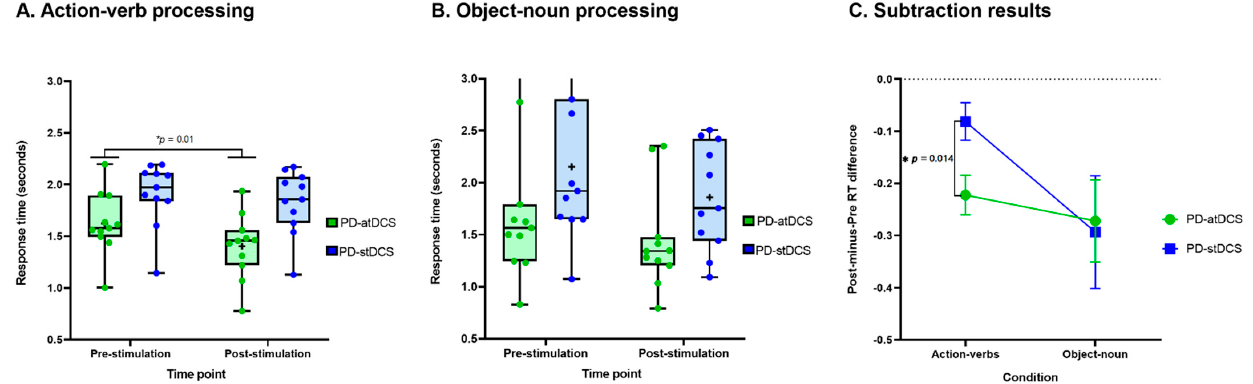
Figure 2. Behavioral results. ( A ) Response times for the action-verb condition revealed faster performance for the PD-atDCS than the PD-stDCS group. ( B ) Response times for the object-noun condition did not differ significantly between groups. ( C ) The subtraction analysis confirmed that the between-group difference proved consistent even when controlling for potential differences in baseline performance. The box and whisker plots in ( A , B ) show the distributions of RTs in the groups, with the boxes representing the inter-quartile range, the horizontal line within the boxes representing the median, and the points representing the individual mean RTs. The error bars in ( C ) represent standard error of the mean (SEM). PD-atDCS, Parkinson’s disease patients undergoing anodal transcranial direct current stimulation; PD-stDCS, Par- kinson’s disease patients undergoing sham transcranial direct current stimulation.